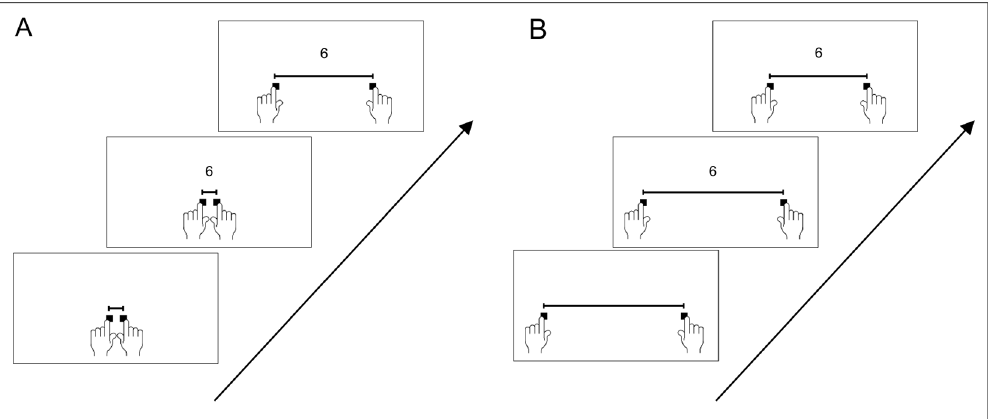
Figure 1. Schematic illustration of the two estimation task conditions. Panel A depicts the increase condition in which participants were supposed to increase the line length of the given Unit 1 until reaching the estimated length of the target number (here, ‘6’). Panel B depicts the decrease condition in which participants had to decrease the line length, starting at a line length of 10, until reaching the estimated length of the target number (here, also